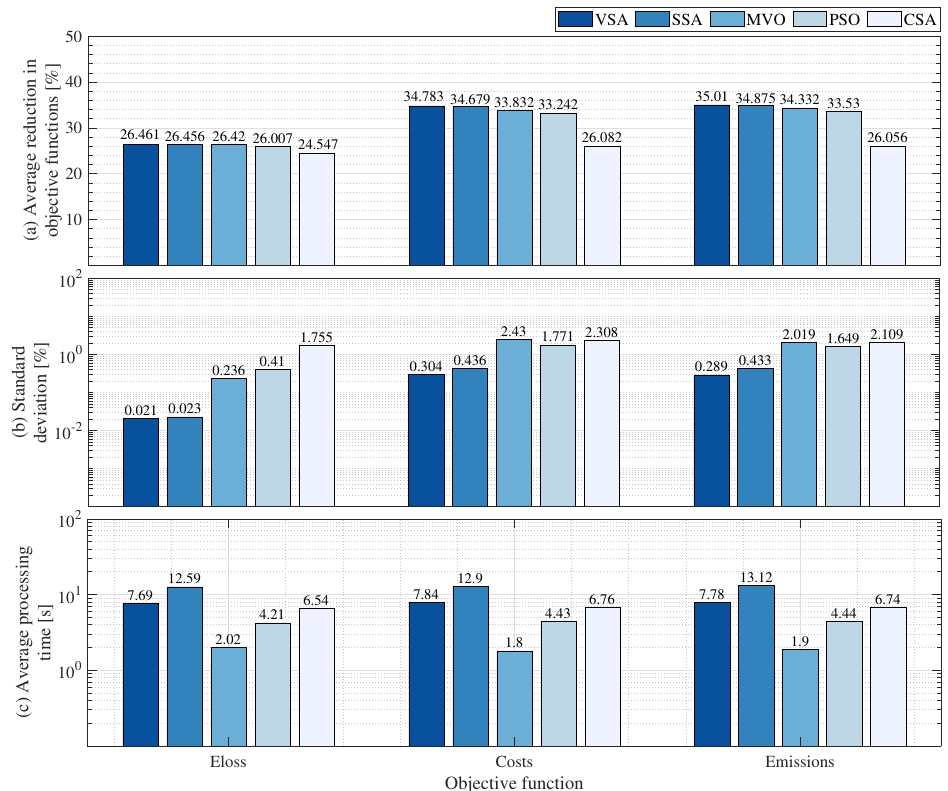
Figure 7. Average reductions, standard deviation, and average processing time obtained by optimiza- tion methods in economical, technical, and environmental conditions used in standalone